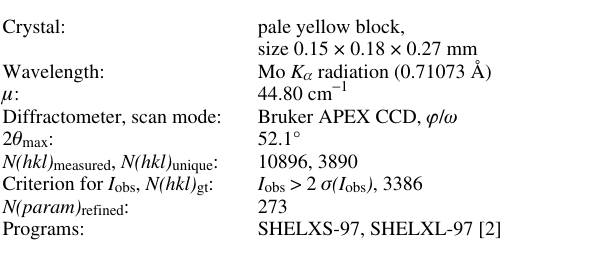
Table 1. Data collection and handling.